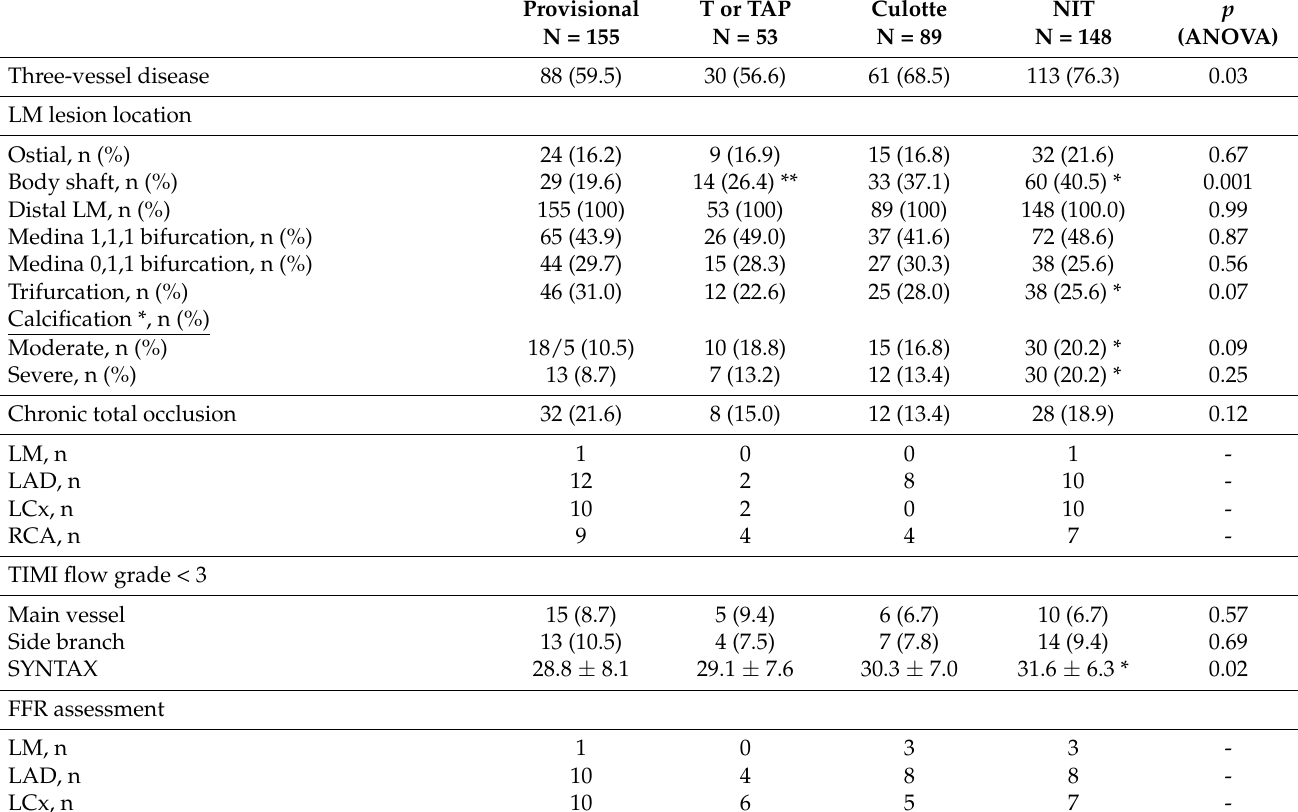
Table 3. Lesions and procedural characteristics of the analysed cohorts of